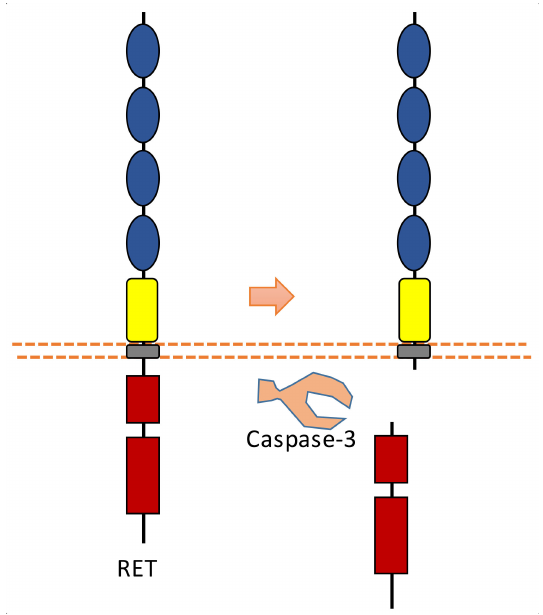
Figure 9. Schematic illustration of proteolytic cleavage in